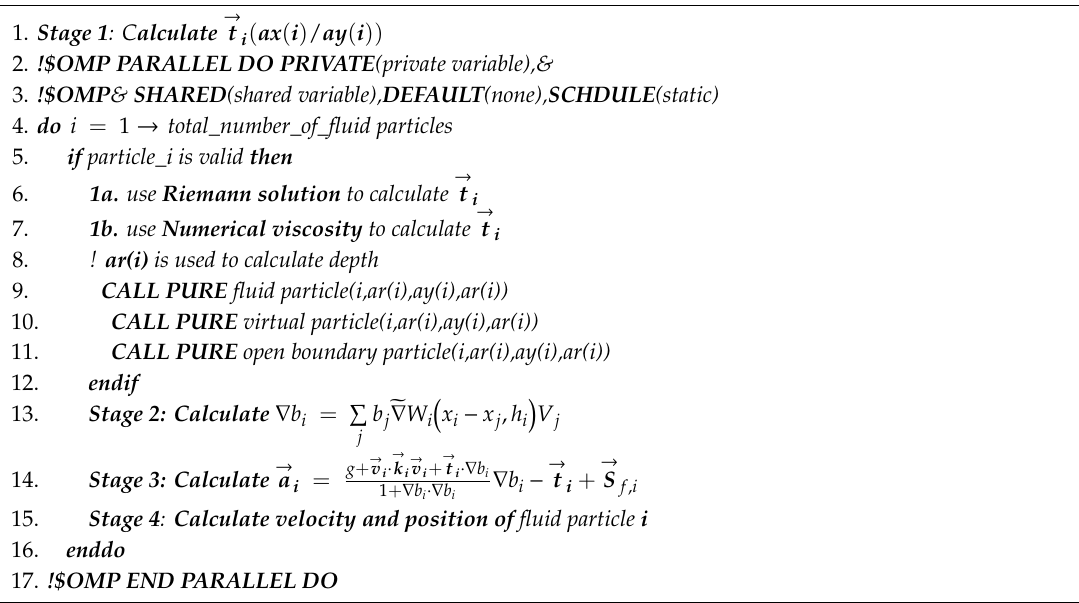
Algorithm 6 : Calculation of acceleration, velocity, and position. The Lagrangian equation of motion for a particle i is d / dt ∂ L / ( ∂ v_i )- ∂ L / ( ∂ x_i ) = 0, where the Lagrangian functional L is defined in term of kinetic energy K and potential energy π as L = K- π , where π is a function of particles position but not